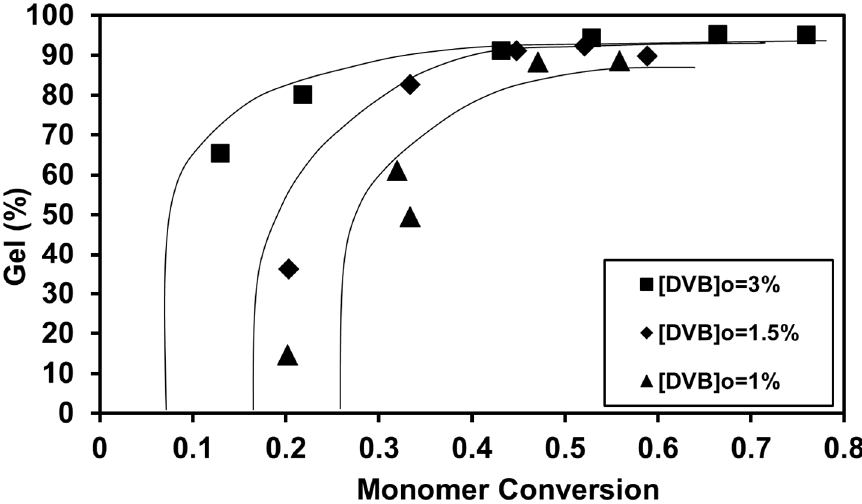
Figure 6. Effect of crosslinker content on gel development for the NMC of STY/DVB in scCO 2 at [TEMPO]/[BPO] = 1.1, T = 120 ◦ C, and P = 207 [TEMPO]/[BPO] = 1.1, T = 120 °C, and P = 207 bar.